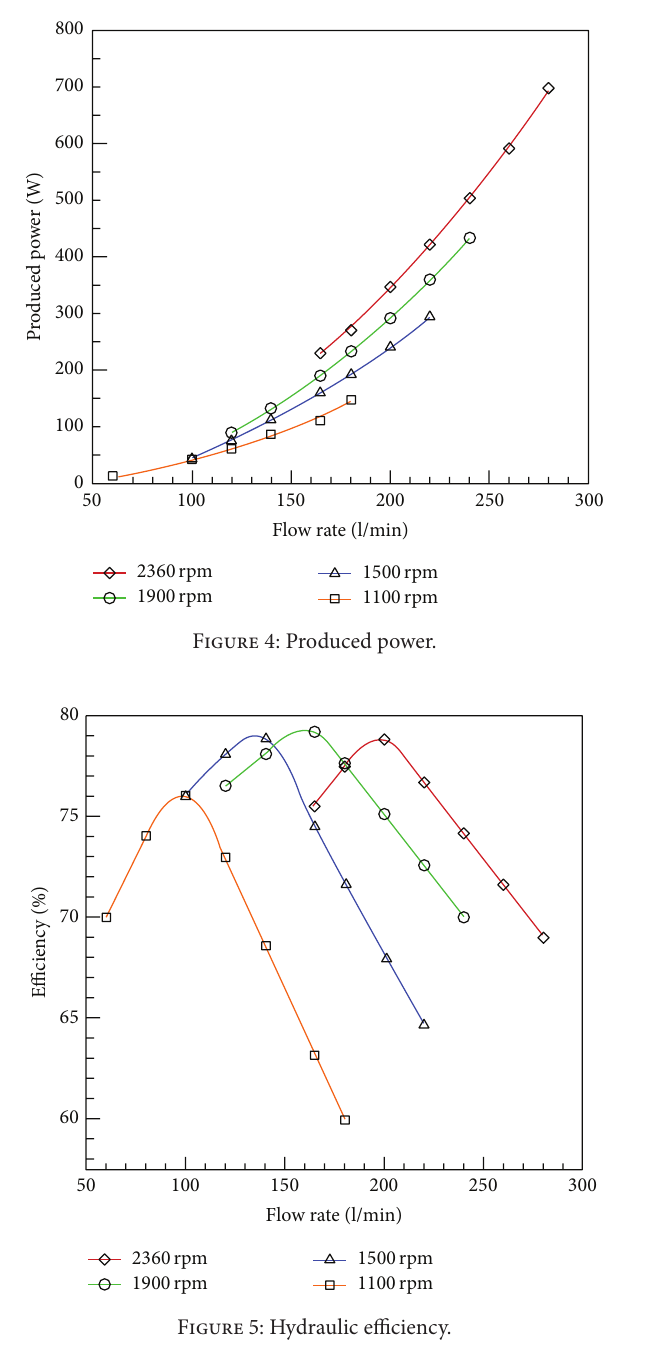
Figure 7: Ratio of unit speed versus ratio of unit